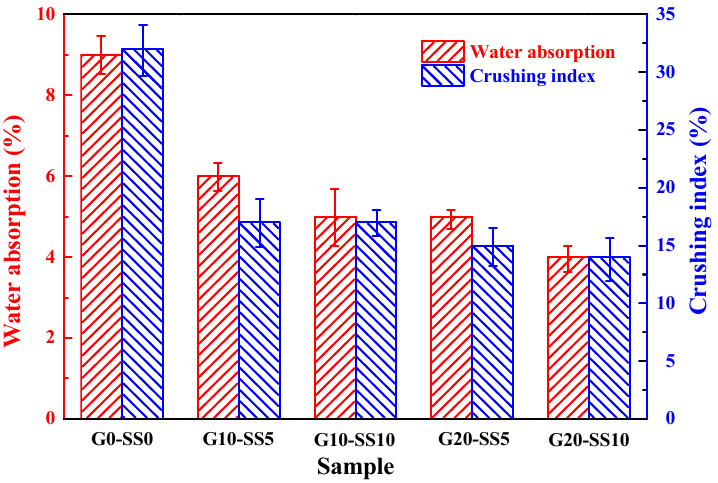
Figure 10. The water absorption and crushing index of the untreated and treated coral